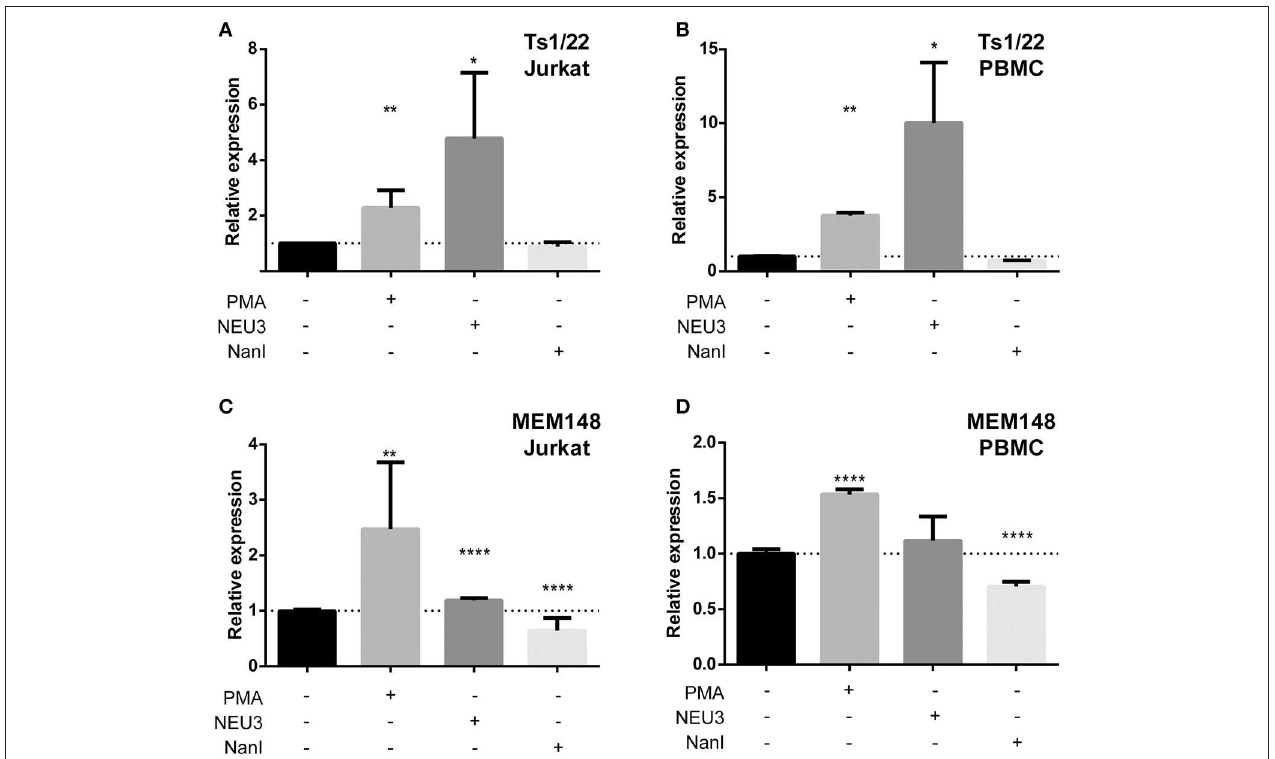
FIGURE 7 | Alteration of LFA-1 epitopes by neuraminidase treatment. Jurkat T cells (A,C) or PBMC (B,D) were treated with the indicated conditions. Treated cells were labeled with primary antibodies (TS1/22 or MEM148), followed by an AF647-conjugated secondary antibody. Cells were fixed with 1% PFA, analyzed by flow cytometry, and normalized to control (buffer) treatment. Data shown are the mean of three replicates for each sample and error is shown as the standard error of mean. Data were compared to the appropriate control using a t -test to determine p -values; * p ≤ 0.05; ** p ≤ 0.01; **** p ≤